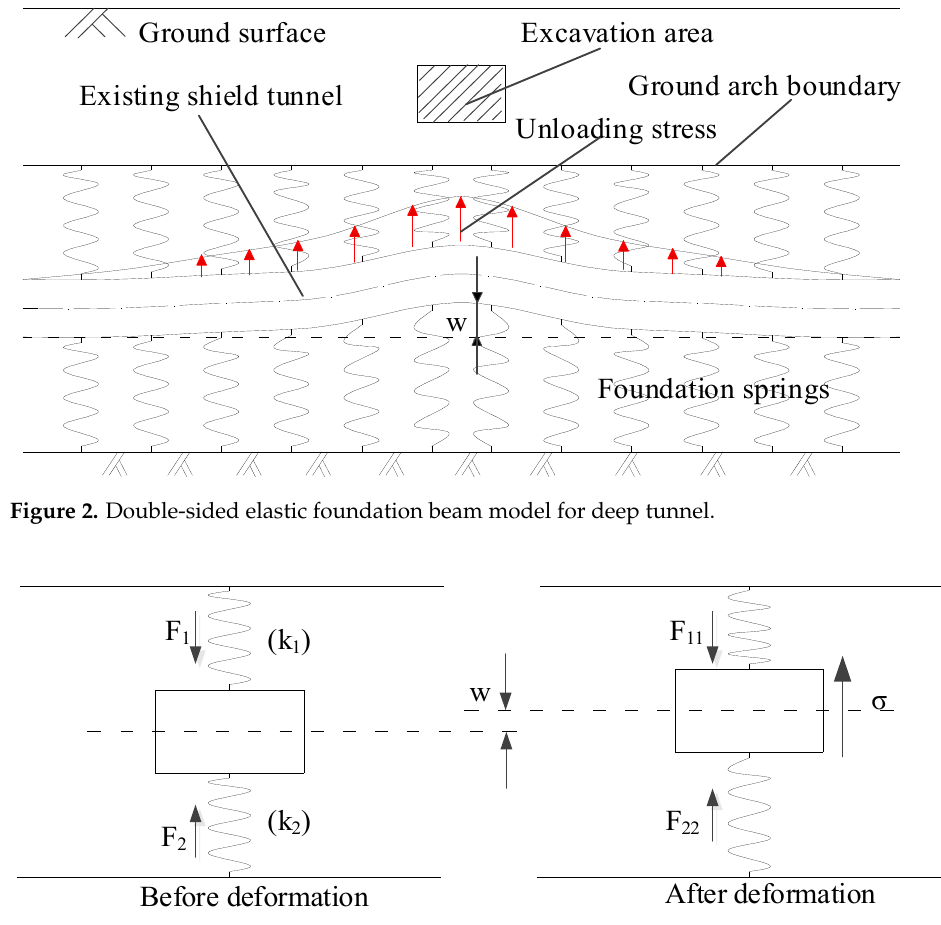
Figure 3. Force diagram of tunnel unit.